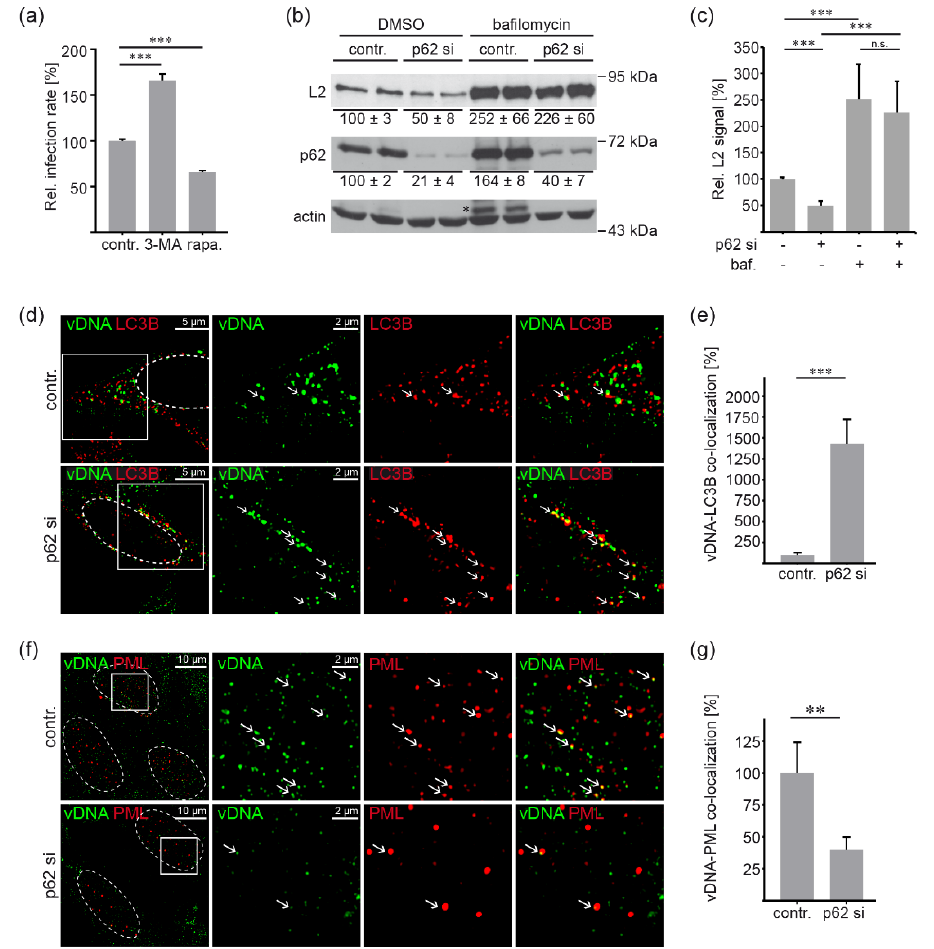
Figure 4. P62 protects HPV16 PsVs from autophagic degradation and supports delivery to PML NBs. ( a ) HPV16 infectivity is affected by autophagy up- and downregulation. HeLa cells were treated with autophagy inhibitor 3-Methyladenine (3-MA, 5 nM), autophagy-inducer rapamycin (rapa., 50 nM) or left untreated, and subsequently infected with HPV16 PsVs for 24 h. Relative infection rate was assessed by luciferase activity and normalized to LDH activity as cell viability control. Infection rate is given as a mean ± SEM, and the mean for control siRNA-treated cells (contr.) was set to 100%. Data ( n = 15 – 32 out of three replicates) were analyzed for significant differences using non-parametric ANOVA (Kruskal – Wallis test): p < 0.0001, with contr. vs. 3-MA p = 0.0009 (3-